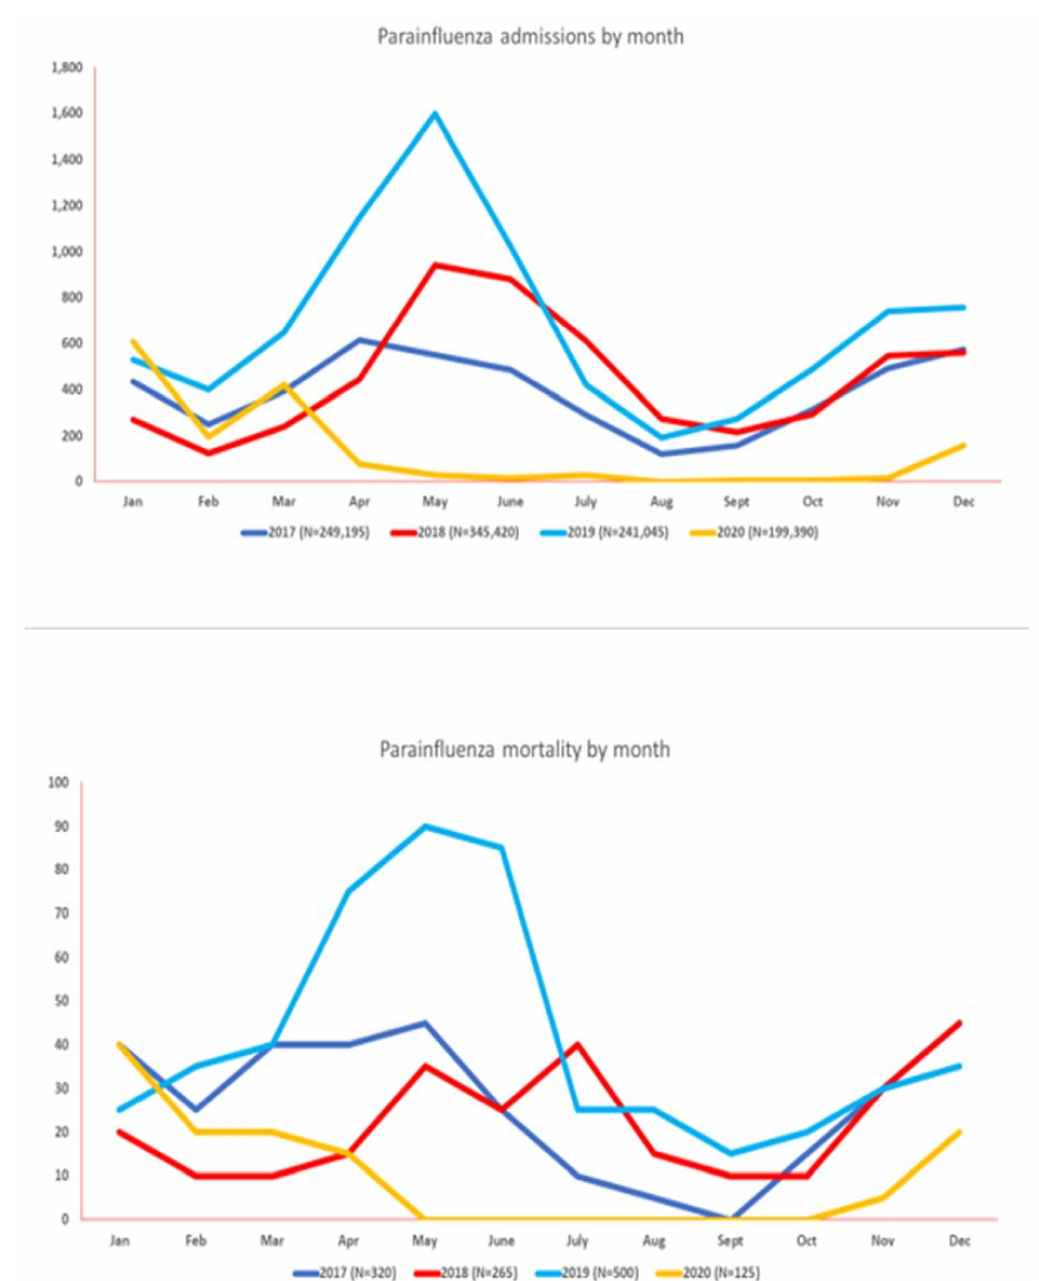
Figure 3. Monthly seasonal variations in the amount of parainfluenza virus activity (hospitalizations at top, mortality at bottom) from